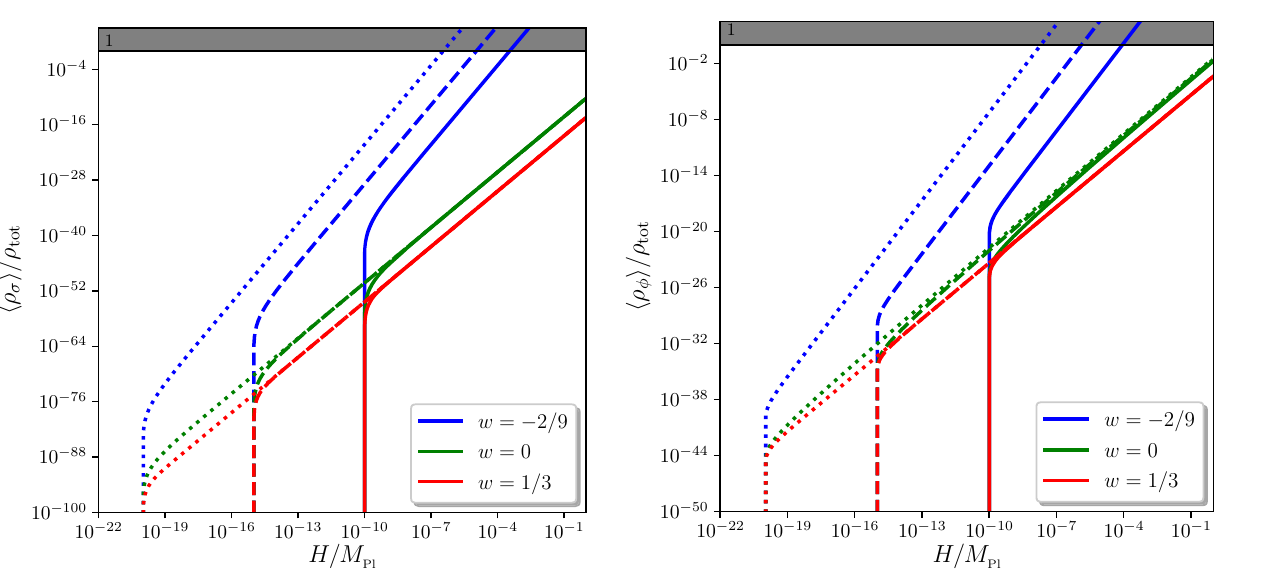
Fig. 1 Left panel: contribution from the shear to the overall energy density in a contracting cosmology, as a function of time labeled by the valueoftheHubblescaleinPlanckianunits.Theresultiscomputedwith Eq. (4.6), using (cid:14) = 0 . 1 Three different equation-of-state parameters are displayed, namely w = − 2 / 9 (blue lines), w = 0 (green lines) and w = 1 / 3 (red lines), for three different initial times, H